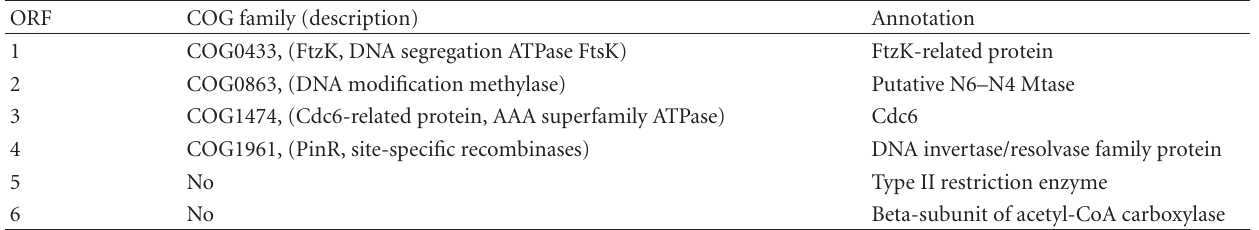
Table 4: Annotation of the predicted ORFs of pPO1 and assignment to existing